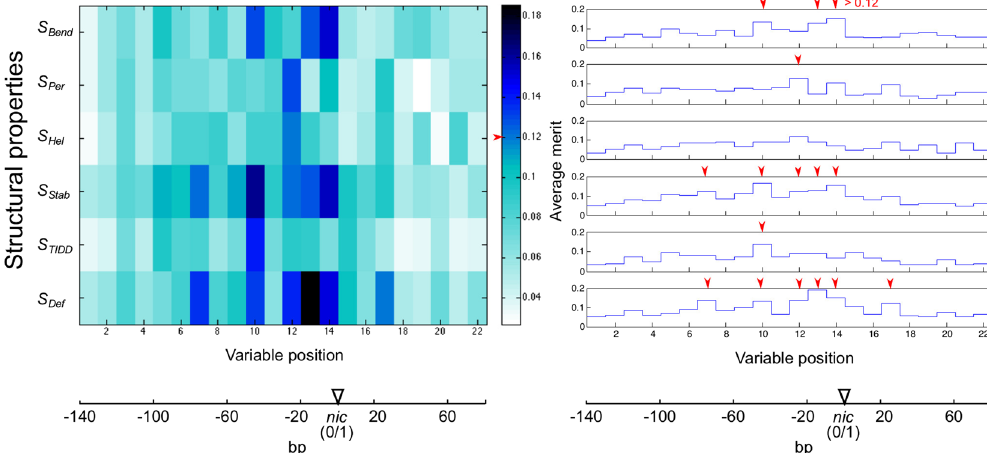
Figure 4. Variable analysis using the ReliefF algorithm. Relative importance (ReliefF Average merit on the y axis) of the structural variables of 6 structural properties (labeled ‘Variable position’) in the oriT regions is shown. The cutoff level of relative importance (Average merit) for the subset of 16 highest ranked variables and the positions of these variables are marked with red arrows.